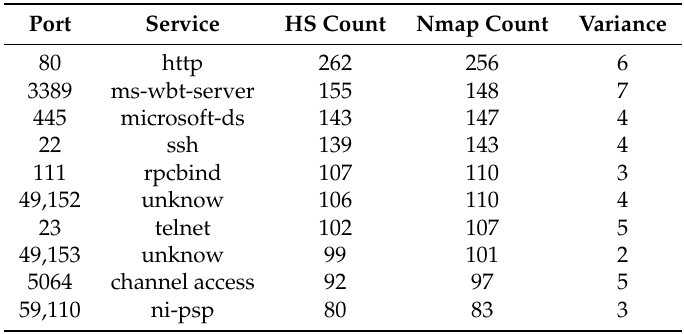
Table 4. The block scanning results of HIRFL Scanner and